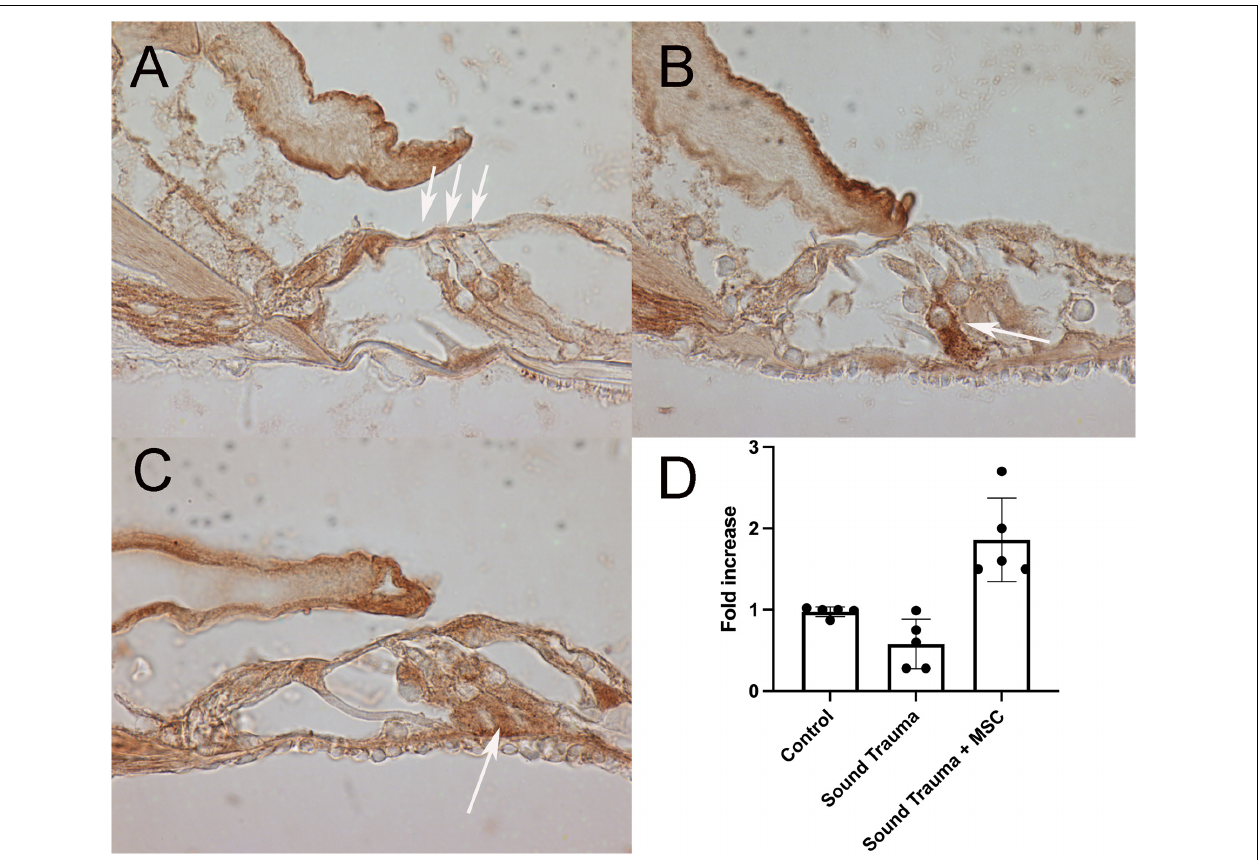
FIGURE 8 | Expression of bcl-2 (brown A–C ) and semi quantitative RT PCR of bcl-2 mRNA (D) . Control cochlea showed bcl-2 expression in the pillar, in the inferior portion of the outer hair cells (arrows) and neurites (A) . After sound trauma there was an occasional increase in bcl-2 immunolabeling in isolated supporting cells (arrow) (B) . Treatment with MSCs after sound trauma increased expression of bcl-2 in supporting cells (arrow C ). Semi quantitative RT-PCR showed reduction of bcl-2 mRNA expression after sound trauma. Treatment with MSC after sound trauma showed a significant up-regulation of bcl-2 mRNA compared to both controls and sound trauma only treated animals ( p = 0.003) (D)